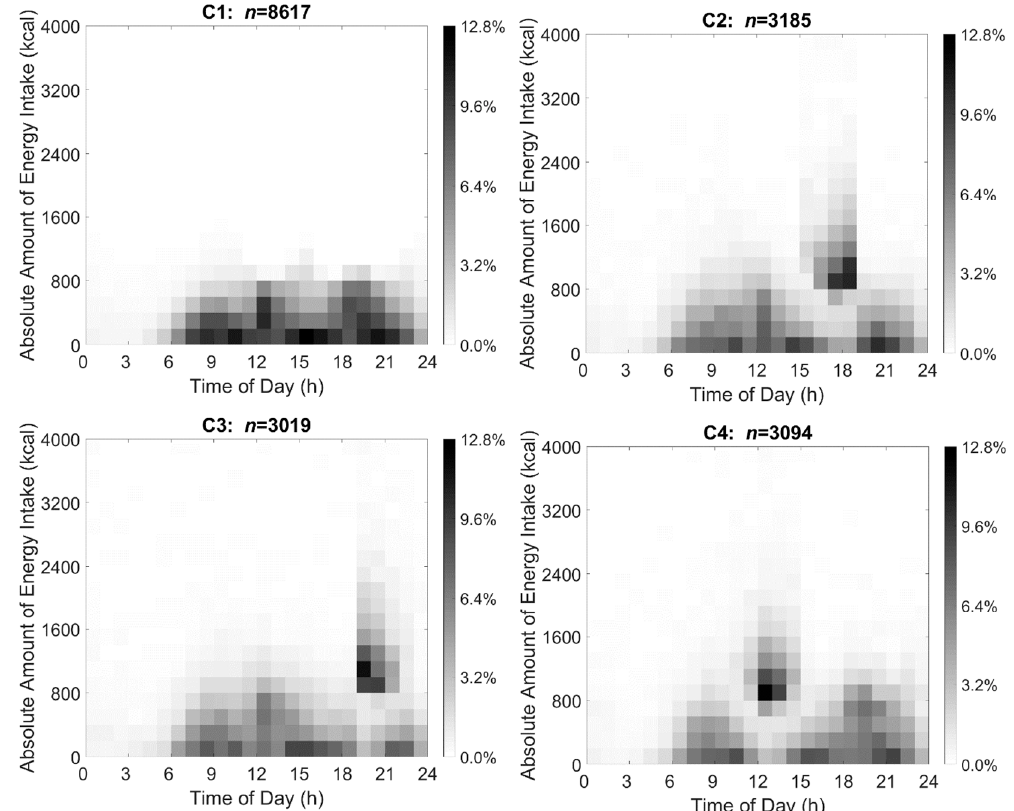
Figure 2. Energy intake heat maps representing four distinct TDPs generated based on data-driven methods for U.S. adults 20–65 years as drawn from NHANES 2007–2016 ( n = 17,915). Absolute energy intake ranges from 0 to 4000 kcal ( y -axis) while timing of intake ranges from 00:00 to 24:00 at hourly increments ( x -axis) for non-pregnant U.S. adults 20–65 years. The proportion of participants in each cluster reporting energy intake is shown through shading ranging from 0.0% to 12.8% of participants in the 4 TDP clusters. Darker shading represents a greater percentage of participants in the cluster reporting the same amount of energy intake at that time. C1, cluster 1; C2, cluster 2; C3, cluster 3; C4, cluster 4; TDP, temporal dietary pattern.